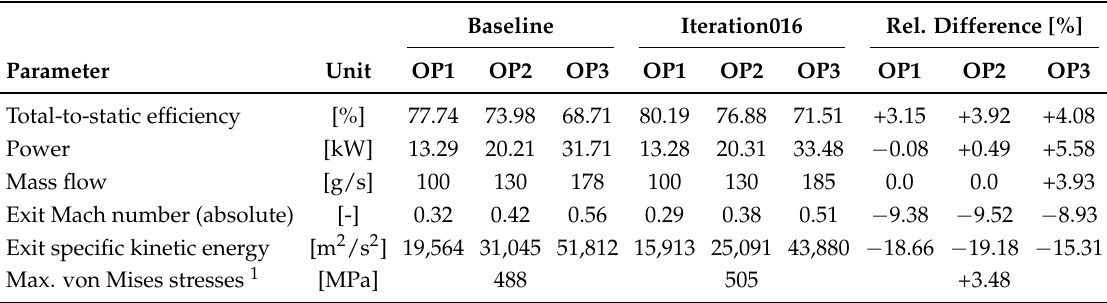
Table 2. Performance summary of baseline and optimized